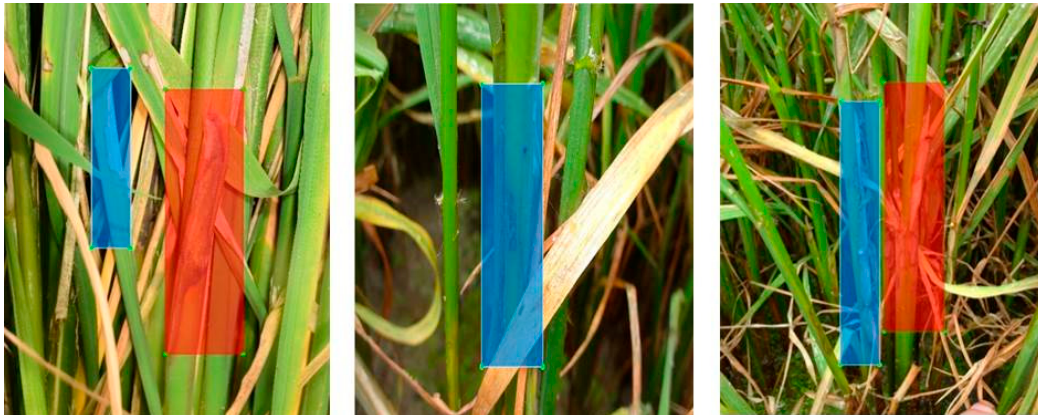
Figure 4. The annotation of rice sheath blight in our datasets. Only lesion spots were annotated, and no withered leaves were annotated. Different colors only denote different annotation boxes, the lesions in the figure are all rice sheath blight. The images were captured in Anhui Province, China, June